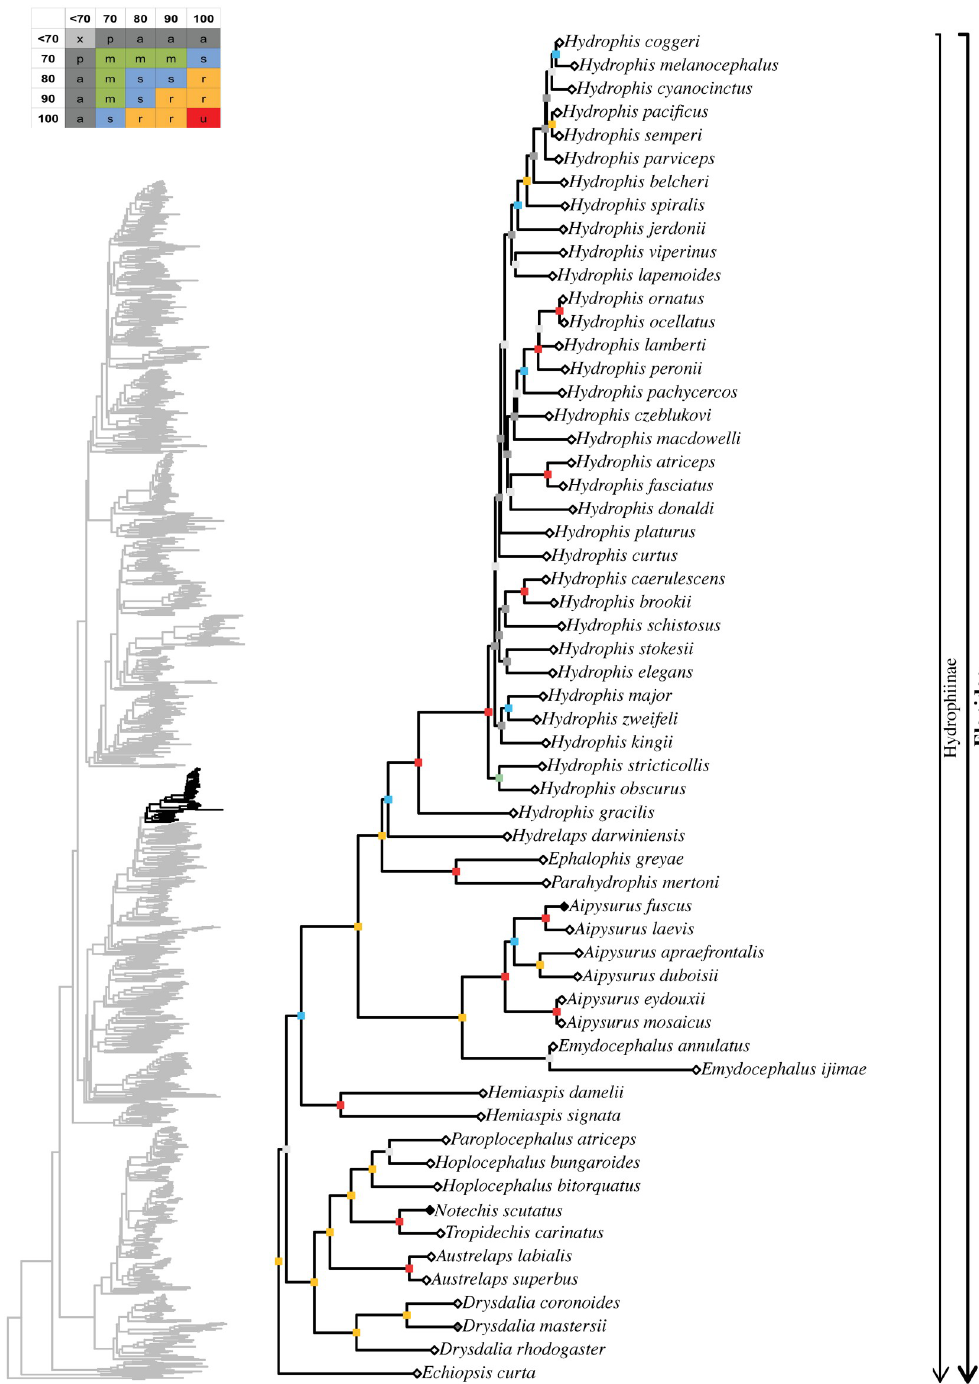
Fig 14. Maximum likelihood species-level phylogeny of Colubroides (continued). Family Elapidae (continued).